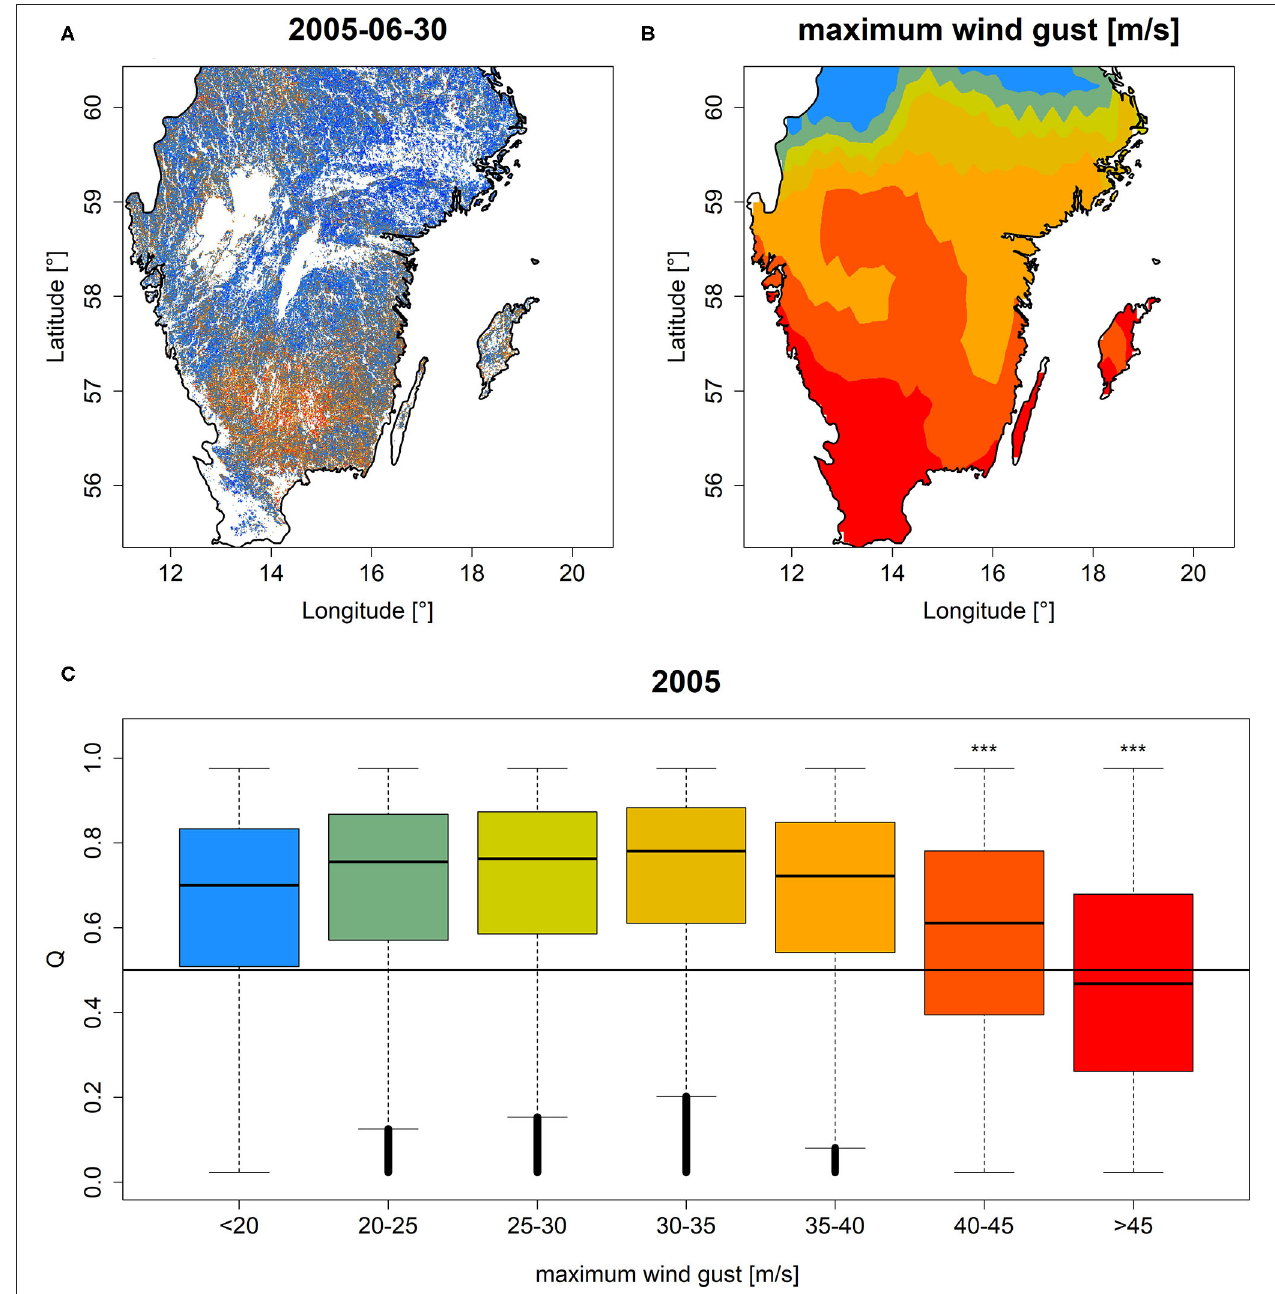
FIGURE 7 | Q mapped for southern Sweden on 30th of June, 2005 (A) along with maximum wind gust speed during the winter storm “Gudrun” in January 2005 (B) and boxplots of Q grouped according to different categories of wind gust speed (C) . ***Significance stars in (C) demarcate a significant ( p < 0.001) one-sided Wilcoxon rank-sum test between subtle storm impact (gust speed < 20 m/s) and the corresponding groups. Colors in (B,C) refer to the same wind gust speed categories as indicated on the x-axis of (C) . Similar results for PDM are shown in Supplementary Figure 11